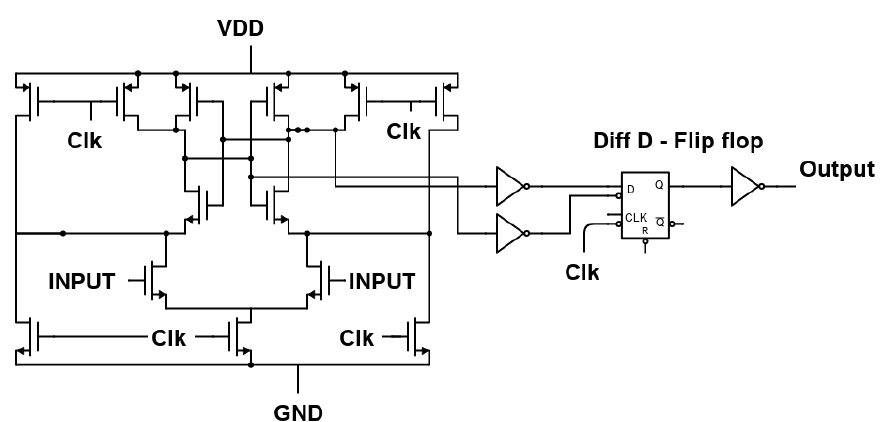
Figure 5. Schematic diagram of the BPSK receiver.Note: IC excludes the coil.